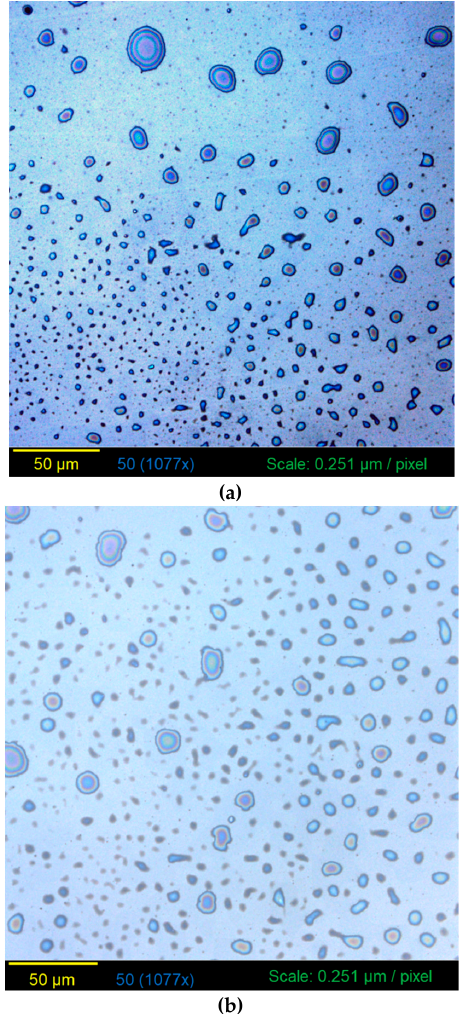
Figure 15. ( a ) Confocal microscopy images of glass plates modified with TS-OE12 aqueous solutions by sonication (GPM1) method. ( b ) Confocal microscopy images of glass plates modified with TS-OE12 aqueous solutions by immersing (GPM2) method.